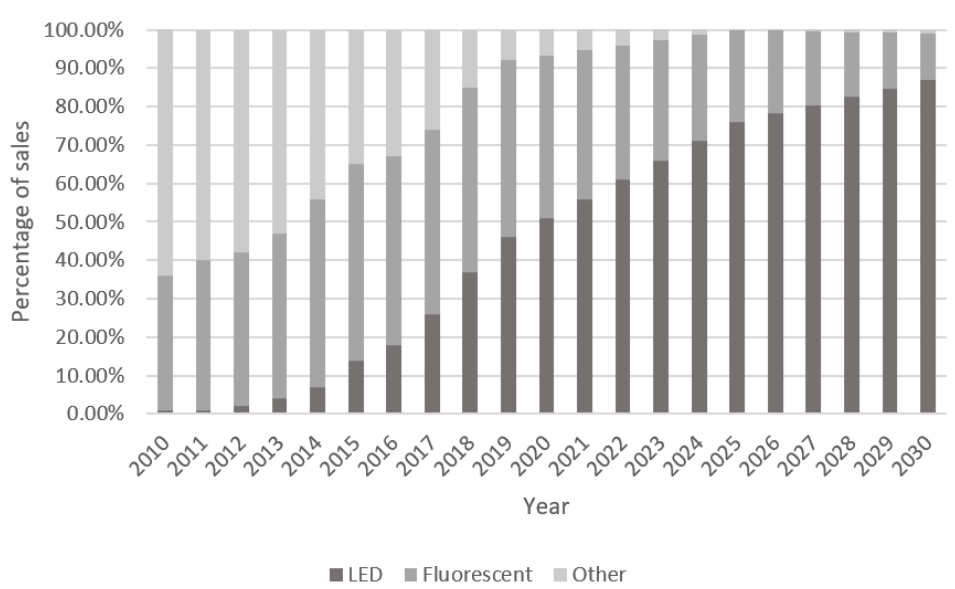
Figure 5. Expected evolution of lighting sales by type based on decarbonization milestones. (Data collected from [66] on 27 May of 2021).